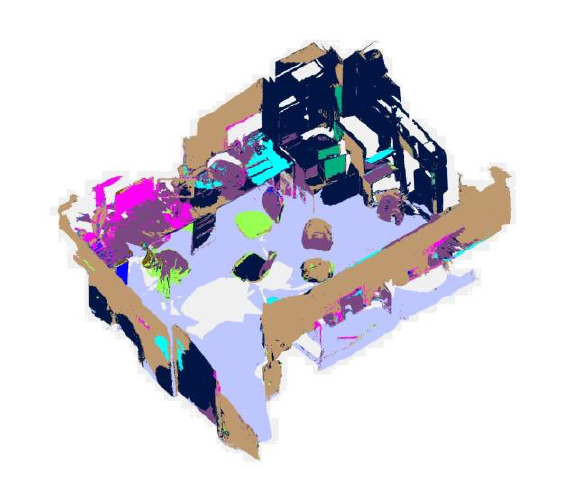
Figure 4. Random Forest classification results (after oversegmentation)